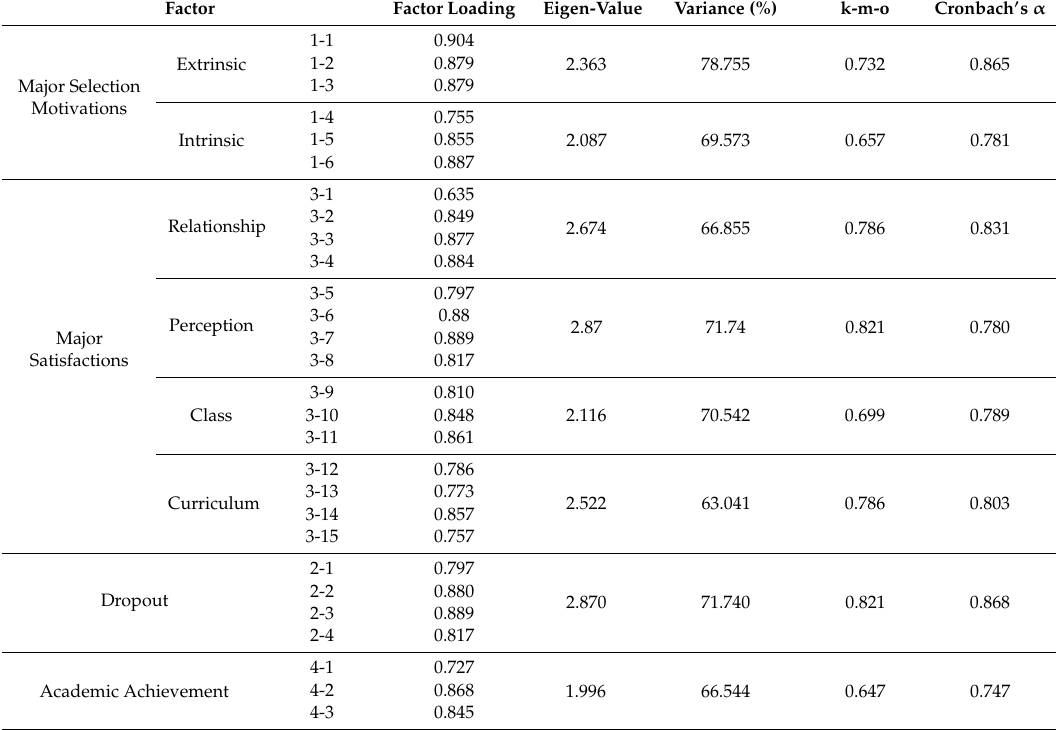
Table 3. Result of validity and reliability